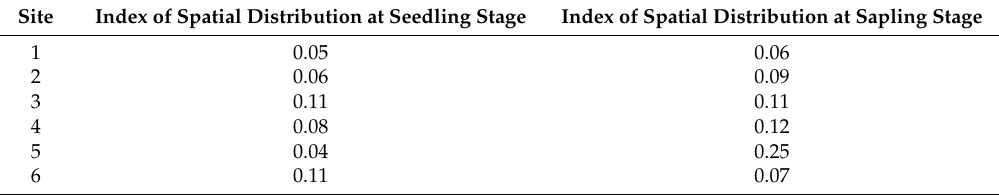
Table 7. Spatial distribution of natural regeneration at seedling and sapling stages at the study